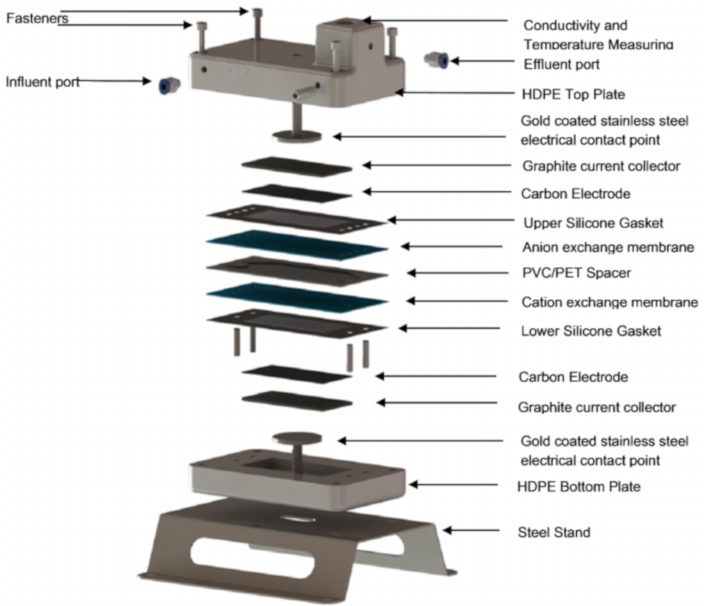
Figure 1. A detailed overview of the in-house built membrane capacitive deionisation cell (MCDI). Reproduced with permission from Nkuna, S.; Development of capacitive deionisation electrodes: optimisation of fabrication methods and composition; published by University of the Western Cape,